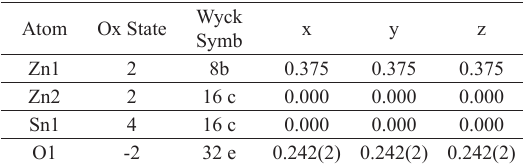
Table 3. Atomic positions obtained from Rietveld